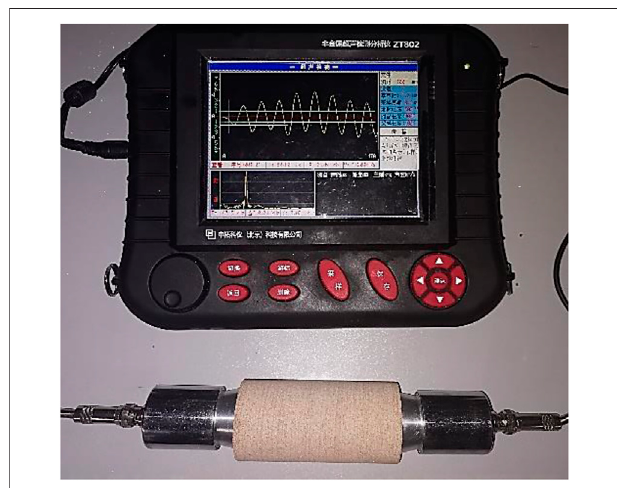
FIGURE 2 | ZT802 non-metal ultrasonic testing analyzer.